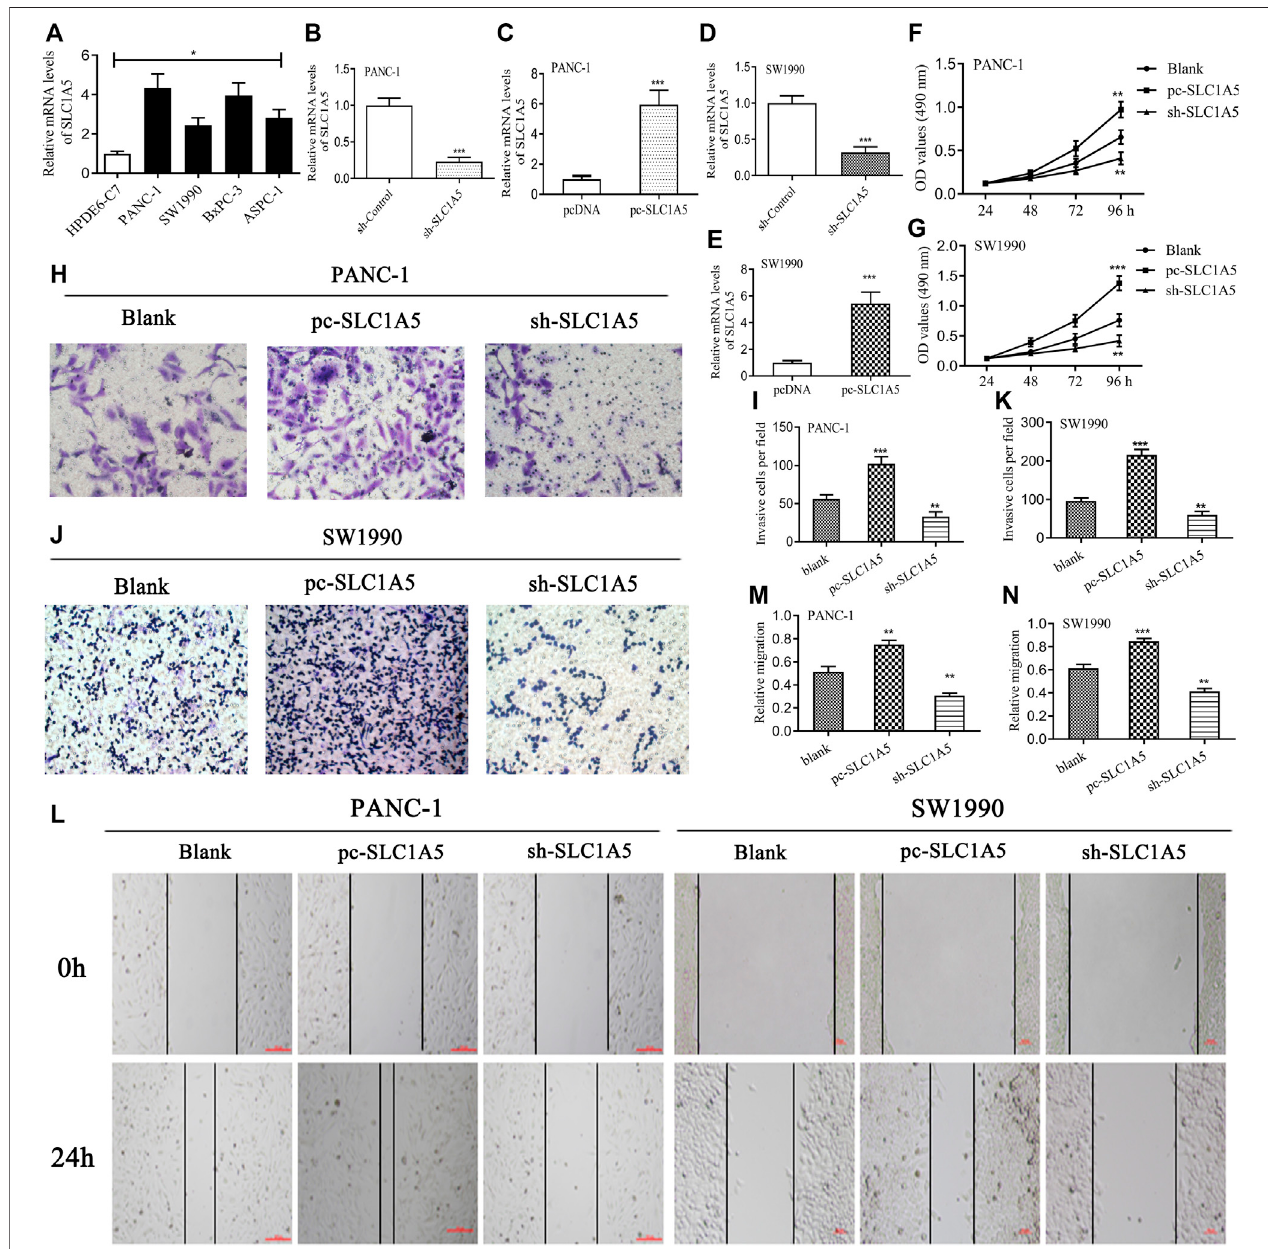
FIGURE 7 | SLC1A5 has promoting effects on the proliferation, migration, and invasion of pancreatic cancer cells. (A) The expressive differences of SLC1A5 between the normal pancreatic duct epithelia and the PC cells. (B – E) Veri fi cation of the transfection ef fi ciency in the PANC-1 and SW1990 cells. (F,G) Assessments of the SLC1A5 effects on the cell proliferation through the MTT assays. (H – K) Assessments of the SLC1A5 effects on the cell invasion through Transwell assays. (L – N) Assessments of the SLC1A5 effects on the cell migration through the wound-healing assays. PC, pancreatic cancer; * p < 0.05, ** p < 0.01, and *** p < 0.001.